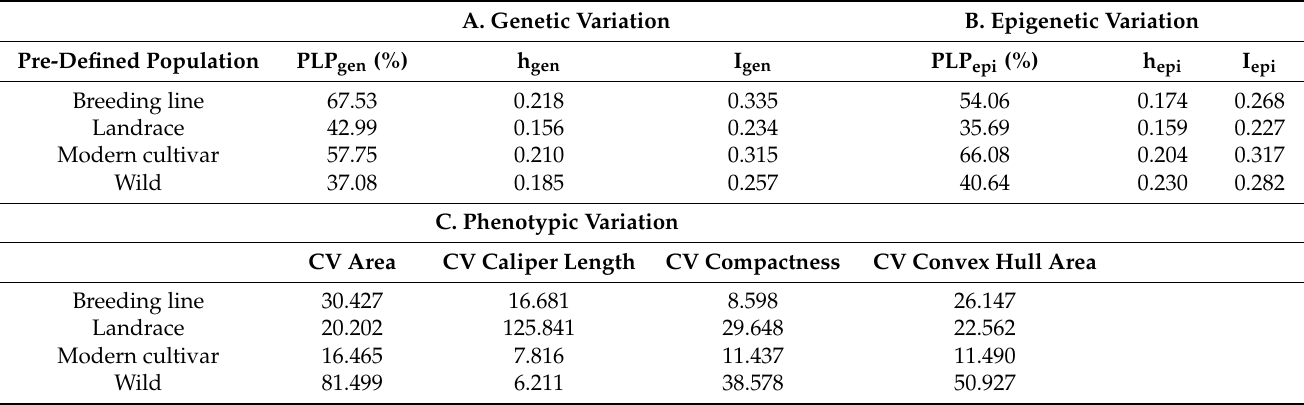
Table 3. Intra-population ( A ) genetic and ( B ) epigenetic variation. PLP (%): percentage of polymorphic loci (PLP gen ) and epiloci (PLP epi ). h: Nei’s genetic diversity (h gen ) and epigenetic diversity (h epi ). I: Shannon’s information index of genetic diversity (I gen ) and epigenetic diversity (I epi ). CV: coefficient of